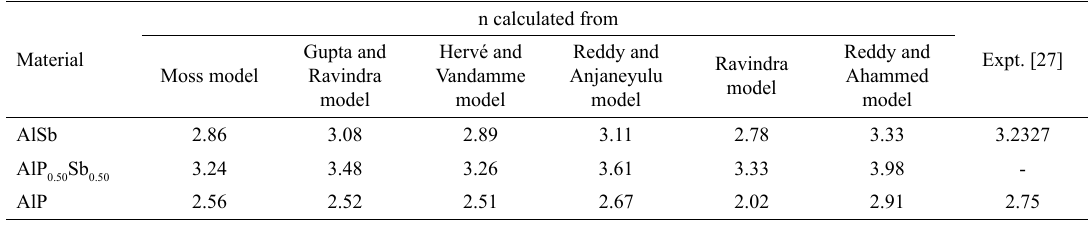
Table 3. Refractive index (n) for AlSb, AlP